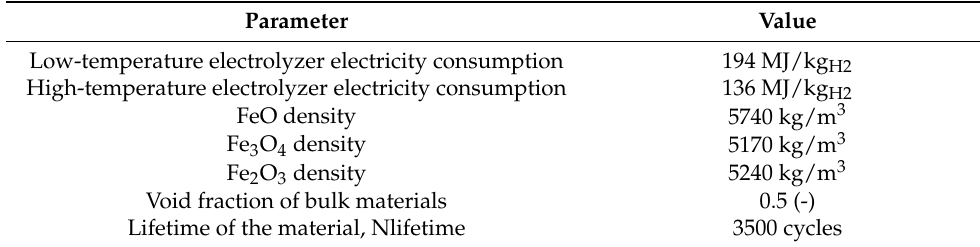
Table 3. Process parameters used for the energy and mass balances. Parameter Value Low-temperature electrolyzer electricity consumption 194 MJ/kg H2 High-temperature electrolyzer electricity